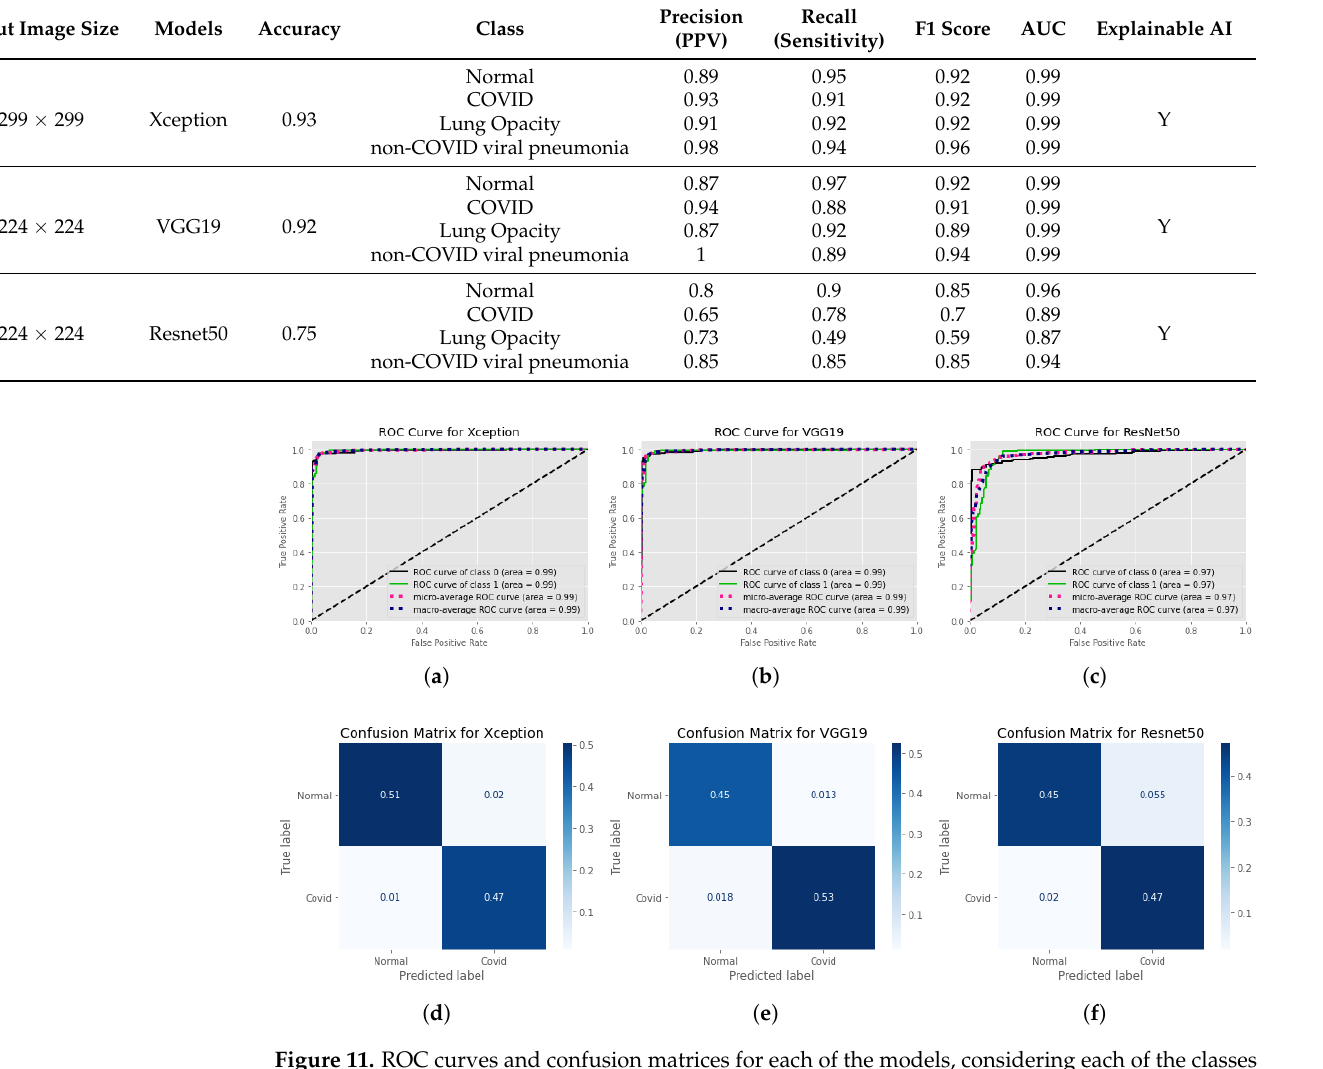
Figure 11. ROC curves and confusion matrices for each of the models, considering each of the classes individually while training the model with standard image size. ROC Curves are presented at Top. Normalized confusion matrices are at Bottom. Left: Xception model’s ROC curve and confusion matrices. Center: Confusion matrices and the ROC curve of the VGG19 model. And finally at right: Resnet model’s ROC curve and confusion matrices. ( a ) ROC curve for Xception model at input image resolution 299 × 299, ( b ) ROC curve for VGG19 at input image resolution 224 × 224, ( c ) ROC curve for Resnet50 at input image resolution 224 × 224, ( d ) Confusion Matrix for Xception model at input image resolution 299 × 299, ( e ) Confusion Matrix for VGG19 at input image resolution 224 × 224, ( f ) Confusion Matrix for Resnet50 at input image resolution 224 ×